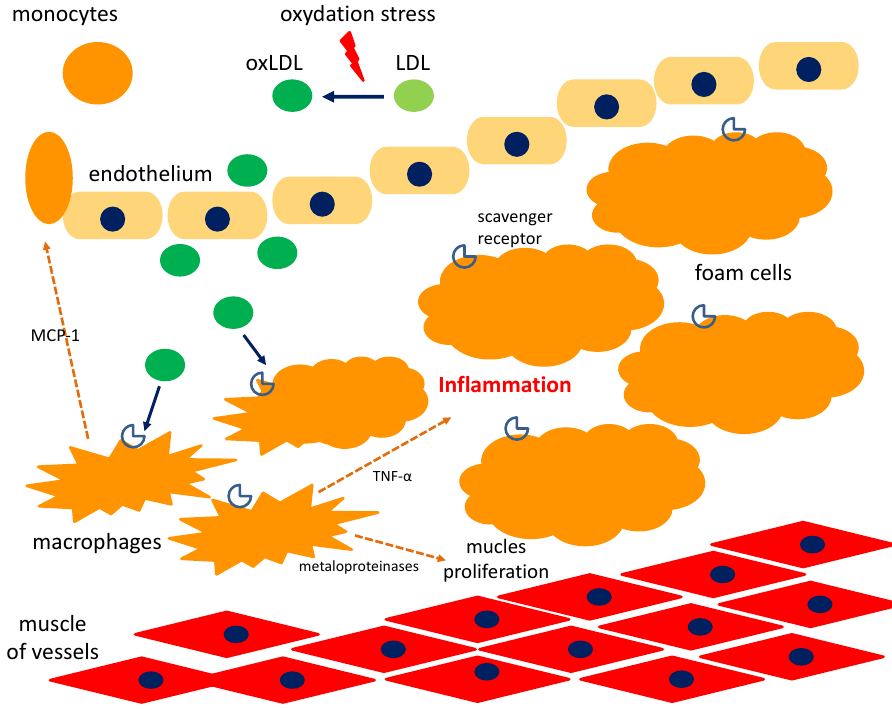
Figure 5. Atherosclerotic plaque formation.